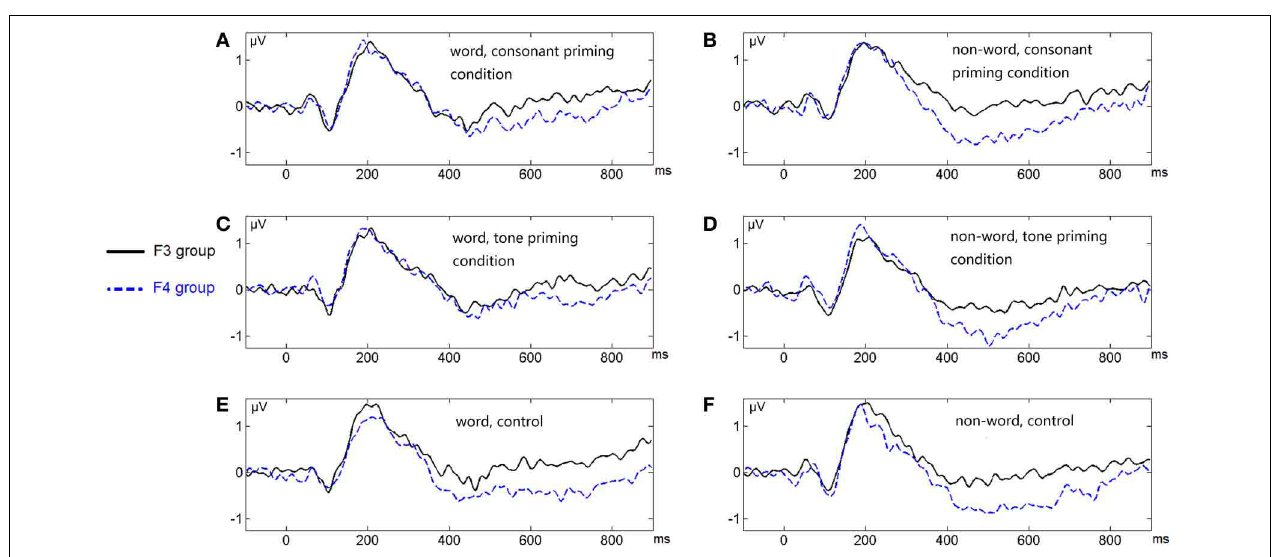
condition; (C) Word, tone priming condition; (D) Non-word, tone priming condition; (E) Word, control condition; (F) Non-word, control condition.